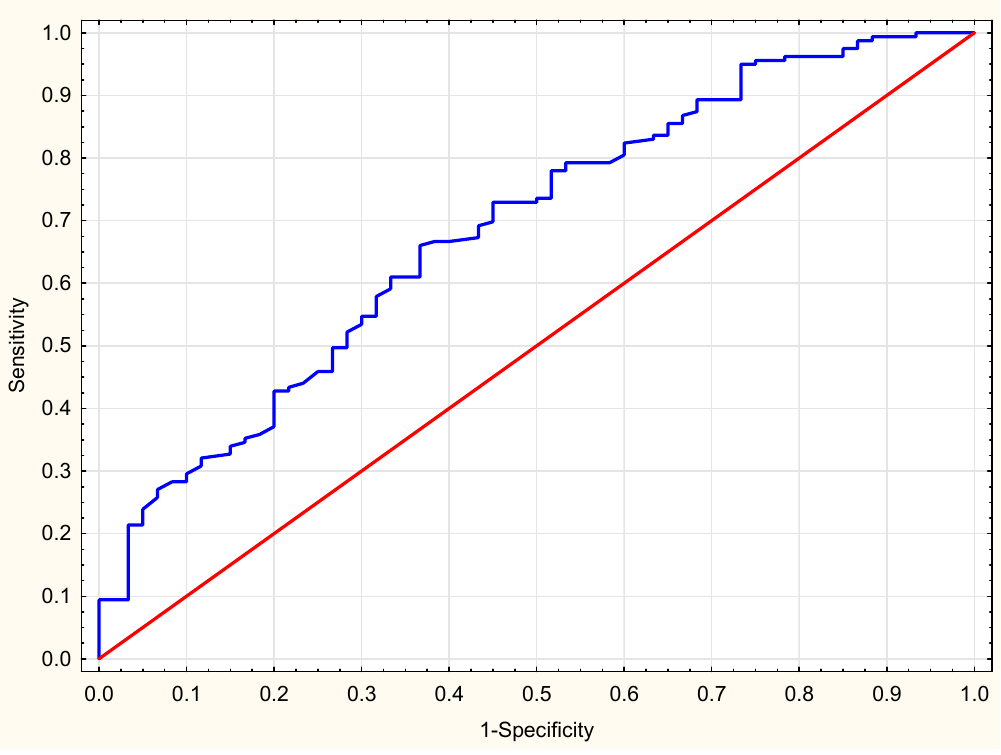
Figure 1. ROC curves for model results with AUC of 0.685.